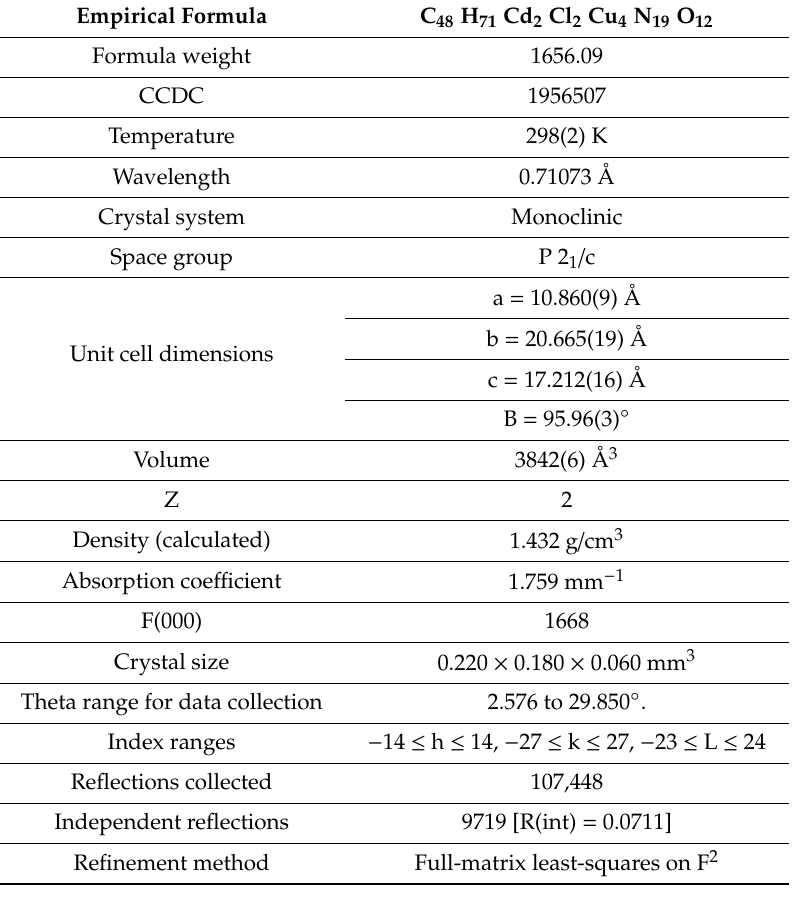
Table 3. Crystal data and structure refinement of the desired